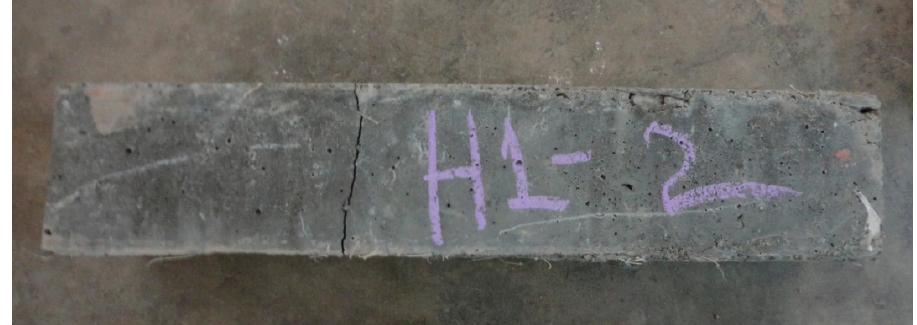
Figure 5. Beam specimen after flexural test